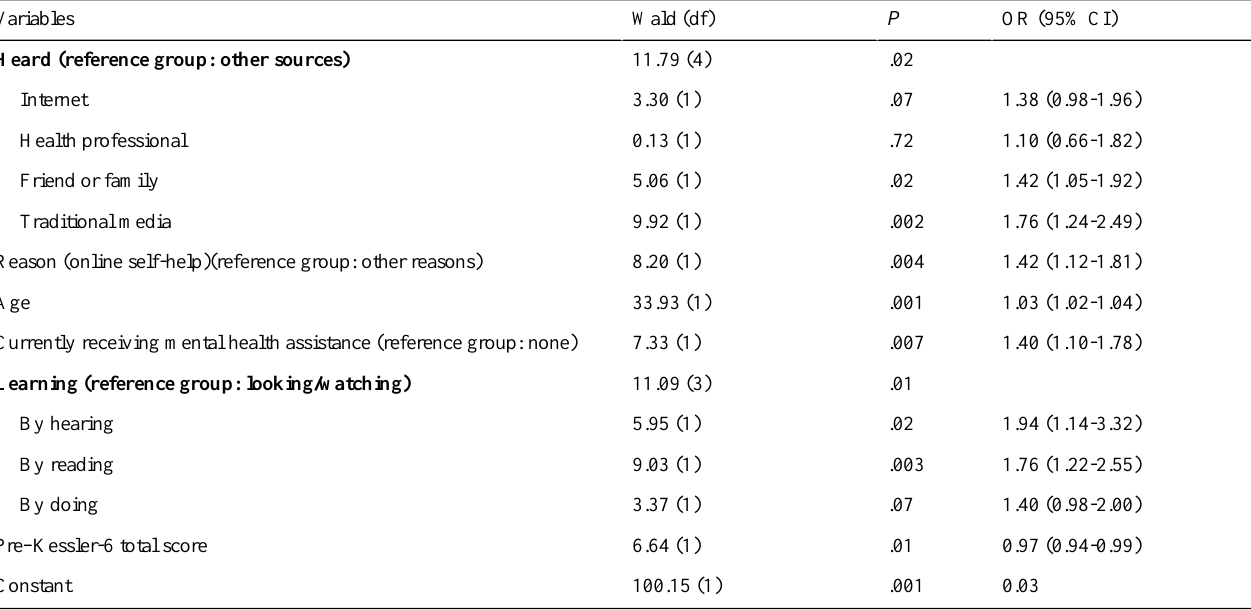
Table 3. Binary logistic regression model for posttreatment assessment